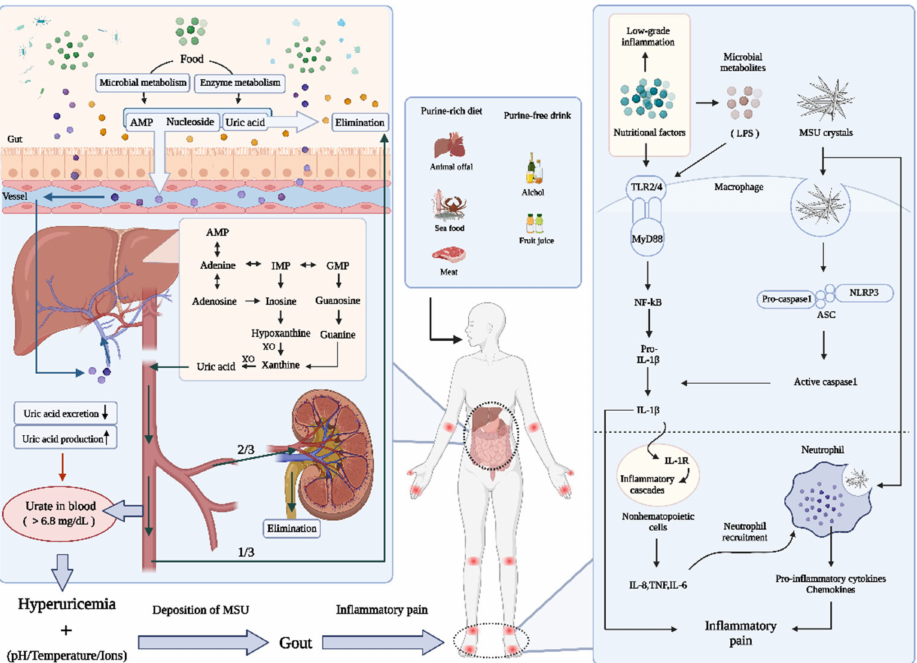
Figure 1. Potential mechanisms of diet-induced gout progression in humans. Diets provide abundant raw materials of purine, which is mainly metabolized in the liver, promoting uric acid production. Meanwhile, it can interfere with the intestinal environment, homeostasis, and urate transport to induce high levels of uric acid, leading to hyperuricemia and ultimately to gout. Additionally, gouty inflammation is caused by IL-1 β production after the activation of NLRP3 by macrophages that ingest MSU crystals, and a second signal is required in humans by stimulating the activation of TLR signaling pathways that can be induced by diets. Moreover, neutrophil infiltration and diet-induced low-grade inflammatory states will exacerbate gouty inflammation. AMP, adenosine monophosphate. ASC, apoptosis-associated speck-like protein containing a caspase recruitment domain. GMP, gua- nine monophosphate. IL, interleukin. IMP, inosine monophosphate. LPS, lipopolysaccharide. MSU, monosodium urate. MyD88, myeloid differentiation factor88. NF- κ B, nuclear factor kappa B. NLRP3, pyrin domain-containing protein 3. TLR, toll-like receptor. TNF, tumor necrosis factor. XO, xan- thine